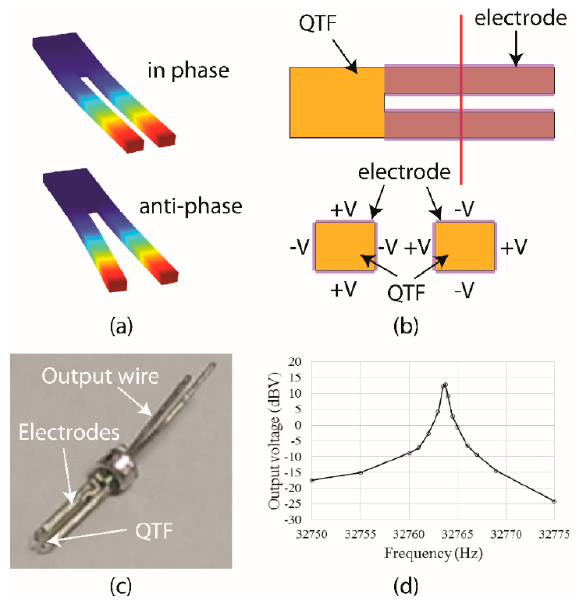
Figure 4. ( a ) For typical QTF resonators, there were two commonly used vibration modes including the in-phase and anti-phase modes. ( b ) To excite the anti-phase vibrations, 8 electrodes were implemented on the surfaces of the prongs of QTF excited via external driving circuits. The red line indicated the cross-section view. ( c ) The photograph of the commercial-available QTF with the resonant frequency of 32.768 kHz sealed in vacuum. ( d ) The measured frequency response of the QTF obtained in vacuum environment. For an input AC voltage of 1V, the output charge was amplified with a charge amplifier (gain = 20 GV / C), the measured Q-factor was approximately 40,000 and resonant frequency was 32.764 kHz which was lower than the spec.